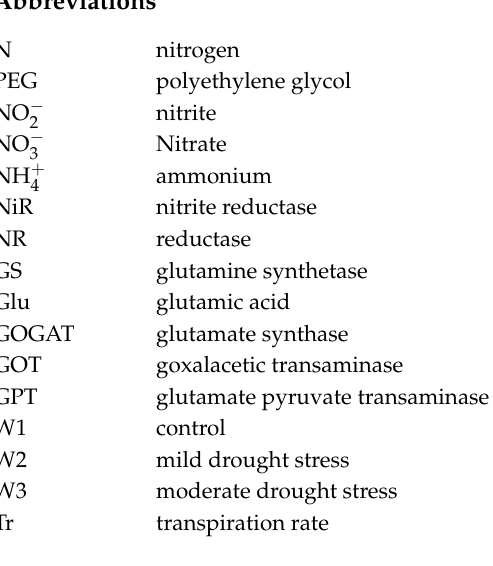
Table S1: The greenhouse environmental data, including solar radiation (w/m 2 ), temperature ( ◦ F), relative humidity (RH, %), photosynthetically active radiation (PAR, µ E). Table S2: Nitrate-N (NO − Ammonium-N (NH + -N) content, free amino acid-N content, plant nitrogen concentration and plant nitrogen 4 content in leaves and roots of pakchoi at the end of the experiment. Table S3: The activity of nitrate reductase (NR), glutamine synthetase (GS), glutamate synthetase (GOGAT), glutamic oxalacetic transaminase (GOT) and glutamic pyruvic transaminase (GPT) in leaves and roots of pakchoi by different drought and nitrogen